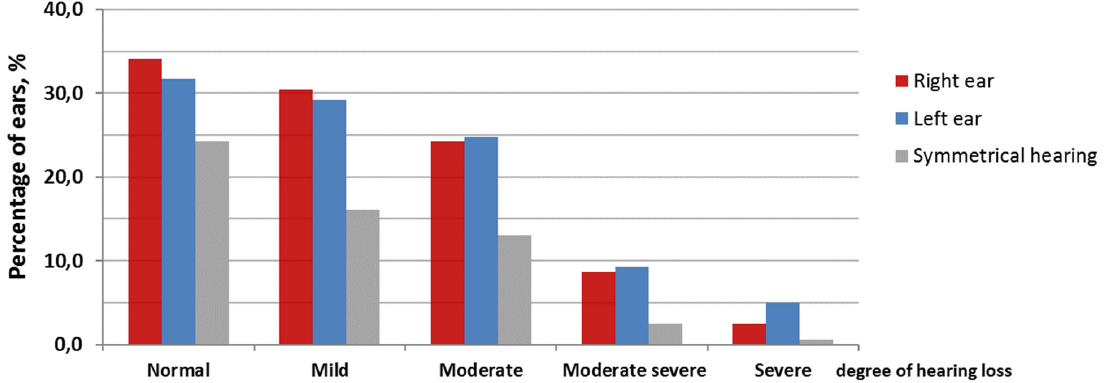
Figure 1. Distribution of average hearing thresholds at 0.5, 1, 2, and 4 kHz (PTA 0.5, 1, 2, 4 ) for the right and left ears in patients with normal hearing and with hearing loss of different degrees.